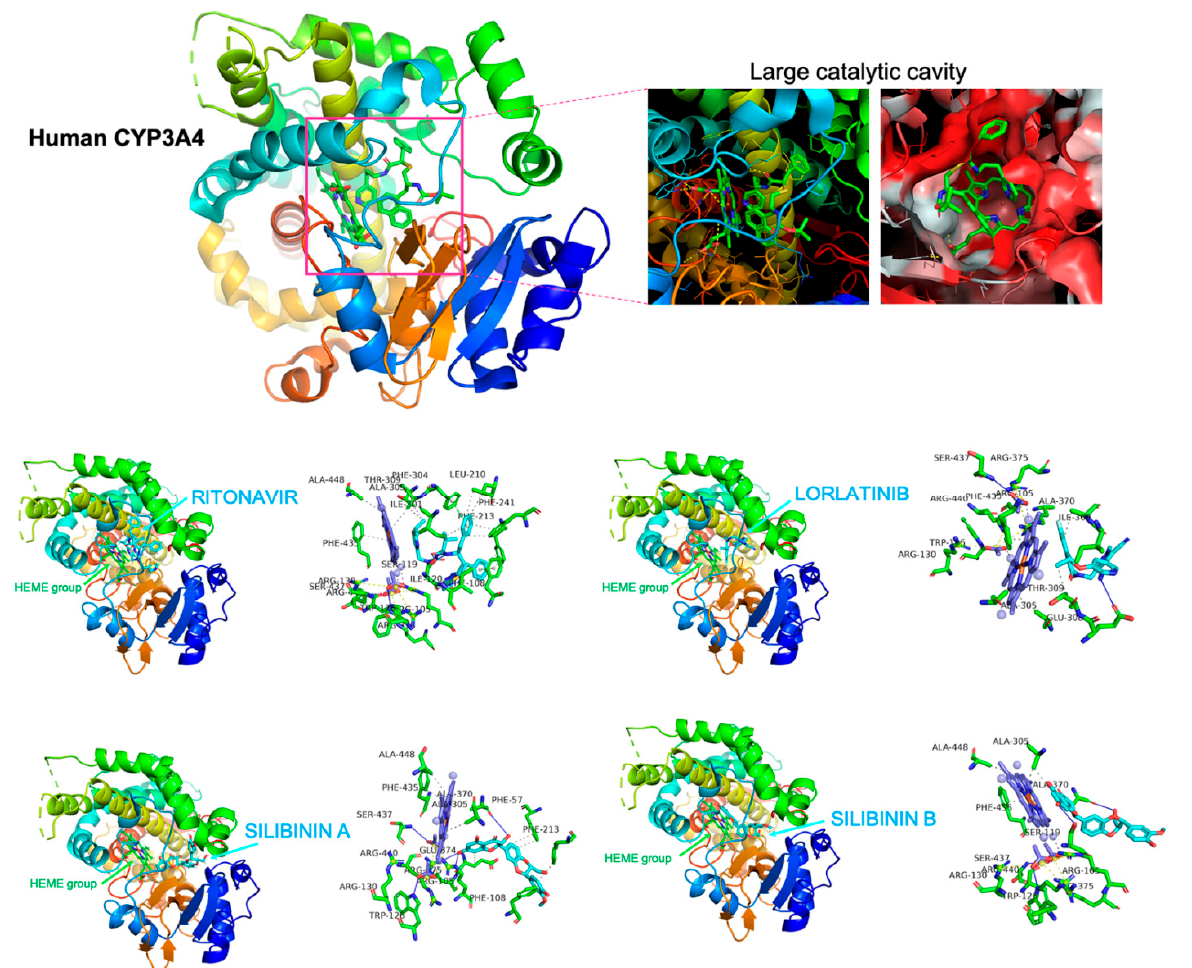
Figure 3. Silibinin does not share the binding mode of lorlatinib to CYP3A4. Figure depicts the backbone of the overall crystal structure of CYP3A4 (7KVS) with rainbow colors showing the best docked poses of silibinin A, silibinin B, ritonavir, and lorlatinib at the catalytic site. Each inset shows the detailed interactions of silibinin docked to CYP3A4, indicating the participating amino acids involved in the interaction and the type of interaction (hydrogen bonds, hydrophilic interactions, salt bridges, II-stacking, etc).